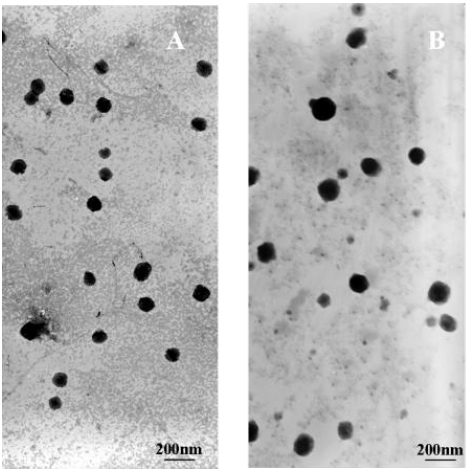
Figure 3. Transmission electron micrographs (TEM) of PLA-PEG-PLL NPs ( A ) and PLA-PEG-PLL NPs/DNA complexes ( B